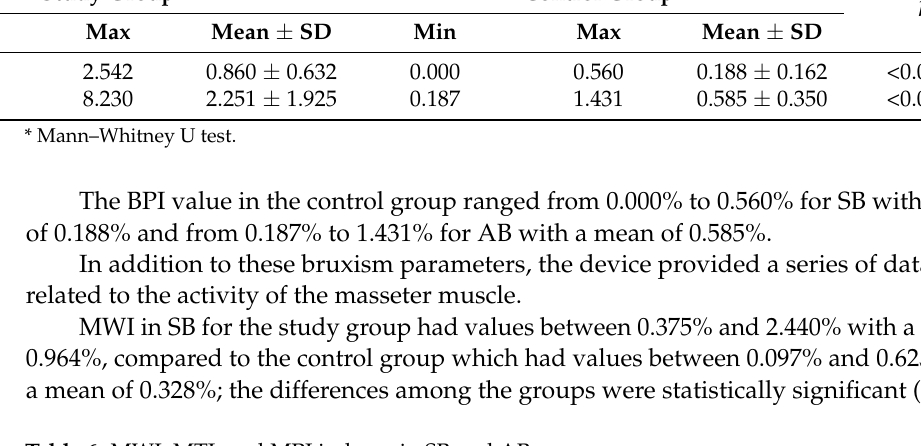
Table 6. MWI, MTI, and MPI indexes in SB and